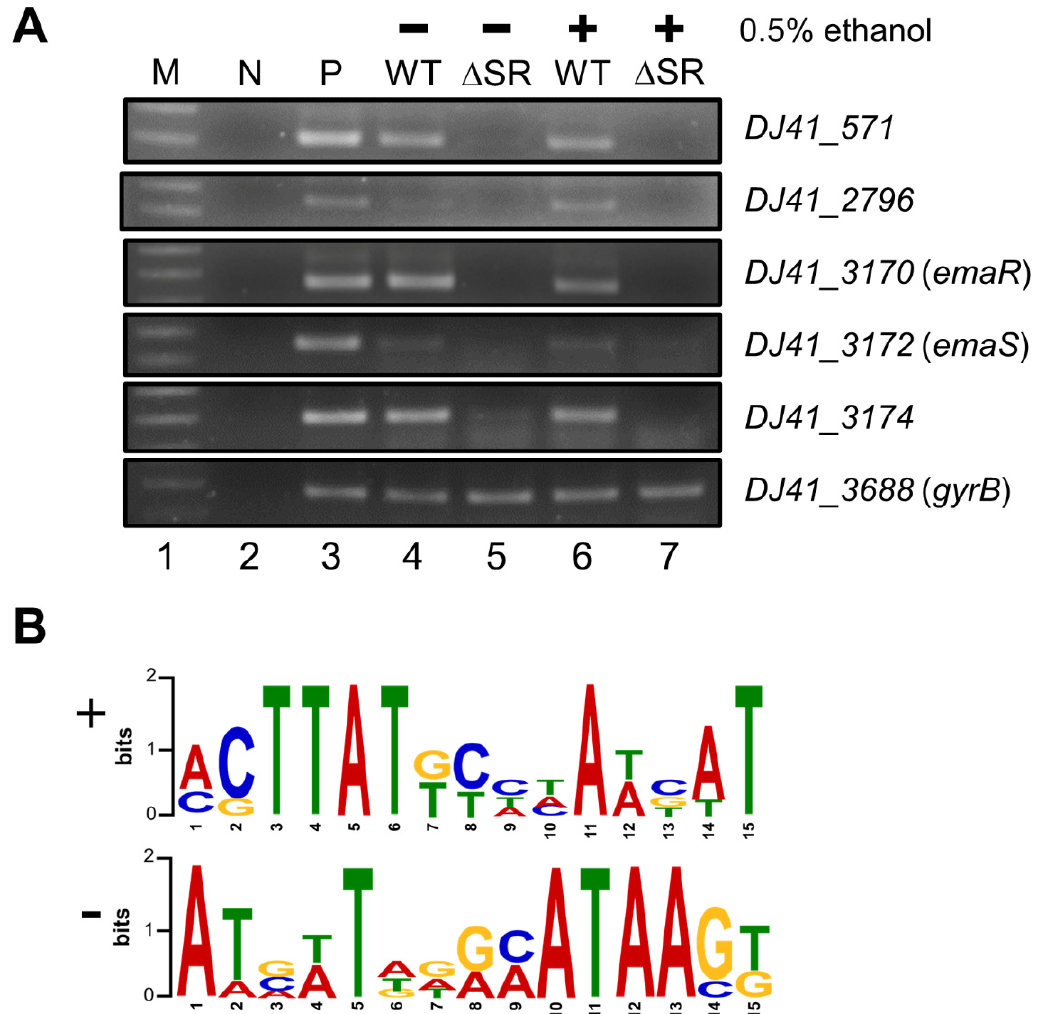
Figure 6. Transcriptional expression analysis and putative EmaR binding box analysis. ( A ) RNA expression analysis by RT-PCR of genes upregulated by EmaSR. Lane 1 is a marker, and lane 2 is non-template DNA used as a negative control. Lane 3 is a positive control with DNA as template. Lanes 4 and 6 contain RNA extracted from wild-type strains cultured without or with 0.5% ethanol. Lanes 5 and 7 contain RNA extracted from the emaSR mutant strain cultured without or with 0.5% ethanol. DJ41_3688 is a gyrase-encoding gene that served as an internal control. ( B ) Putative EmaR binding box analysis by MEME. The upper panel is the highly conserved 15 bp-sequence on the positive strand (+). The lower panel is the highly conserved 15 bp-sequence on the negative strand